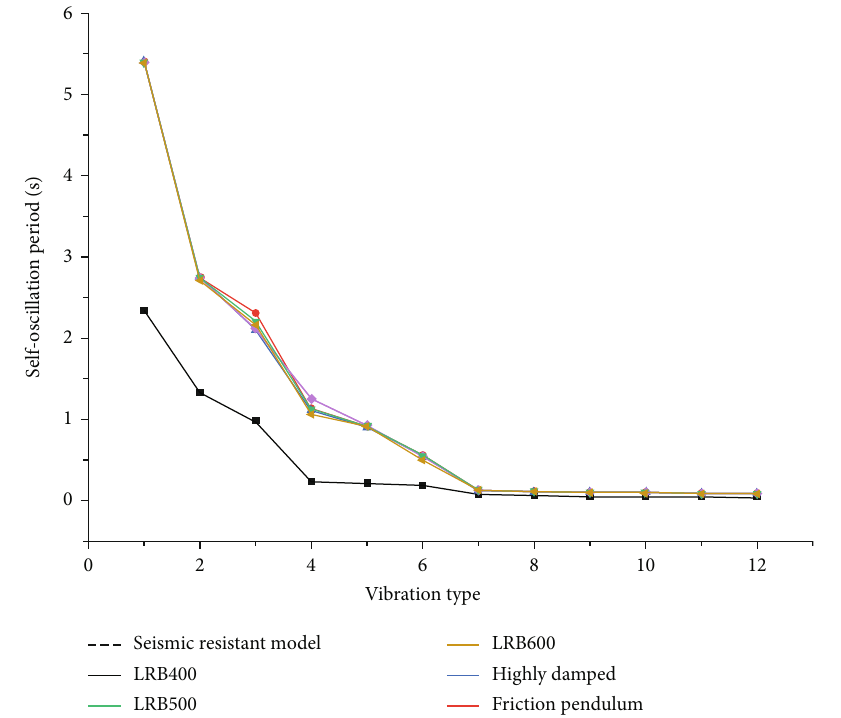
Figure 5: Periodic comparison between the original structure and the fi ve types of seismic isolation structures.